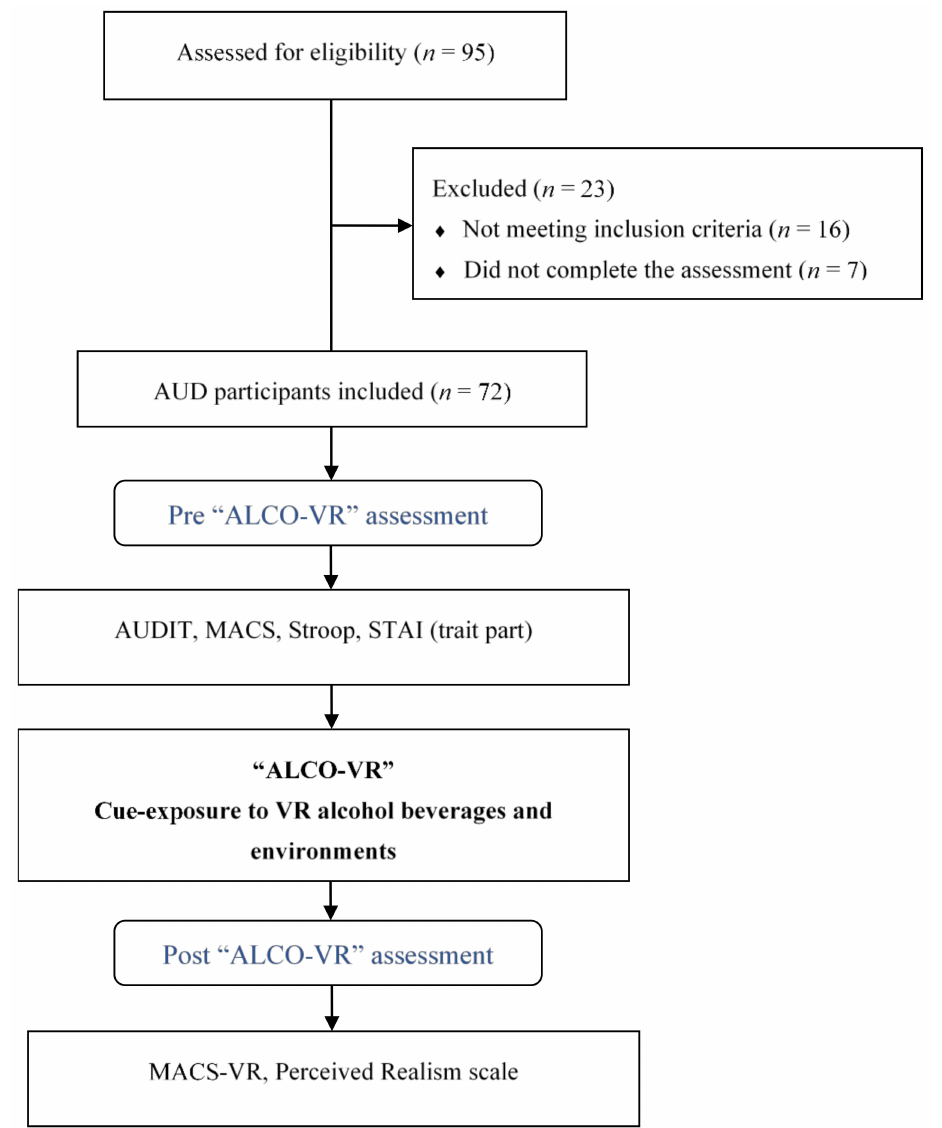
Figure 2. Flowchart of the study. AUD = alcohol use disorder; AUDIT = Alcohol Use Disorder Identification Test; MACS = multidimensional alcohol craving scale; MACS-VR = multidimensional alcohol craving scale-virtual reality; STAI = trait- anxiety inventory; VR = virtual